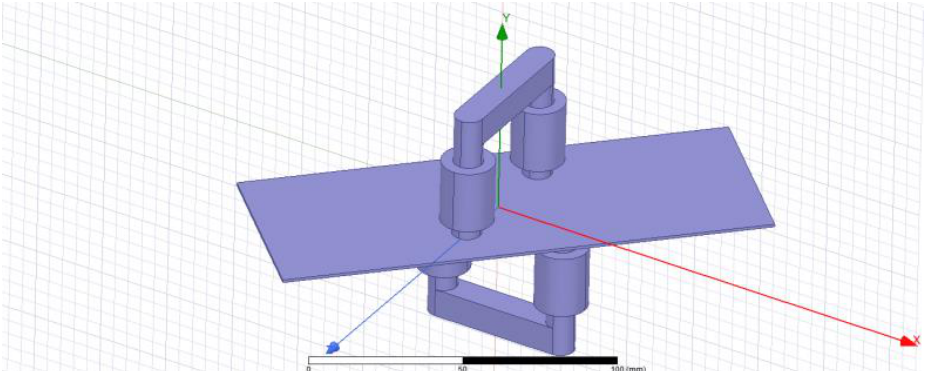
Figure 2. Simulation model for excitation device. Table 1. Properties of the excitation coil.